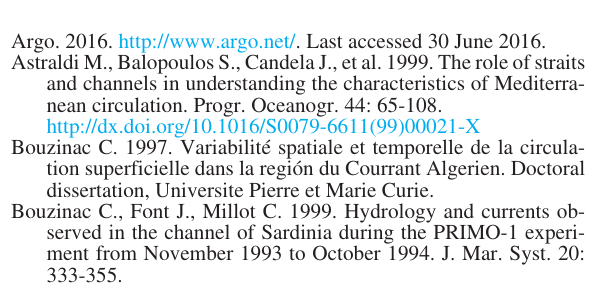
Fig. 6. – In 2011 Jordi Font received the National Arts Award on Scientific Thought and Culture. The photo shows Font after re- ceiving the prize from Francesc Guardans, former president of the National Council of Arts and Culture of the Catalan government (Foto ©